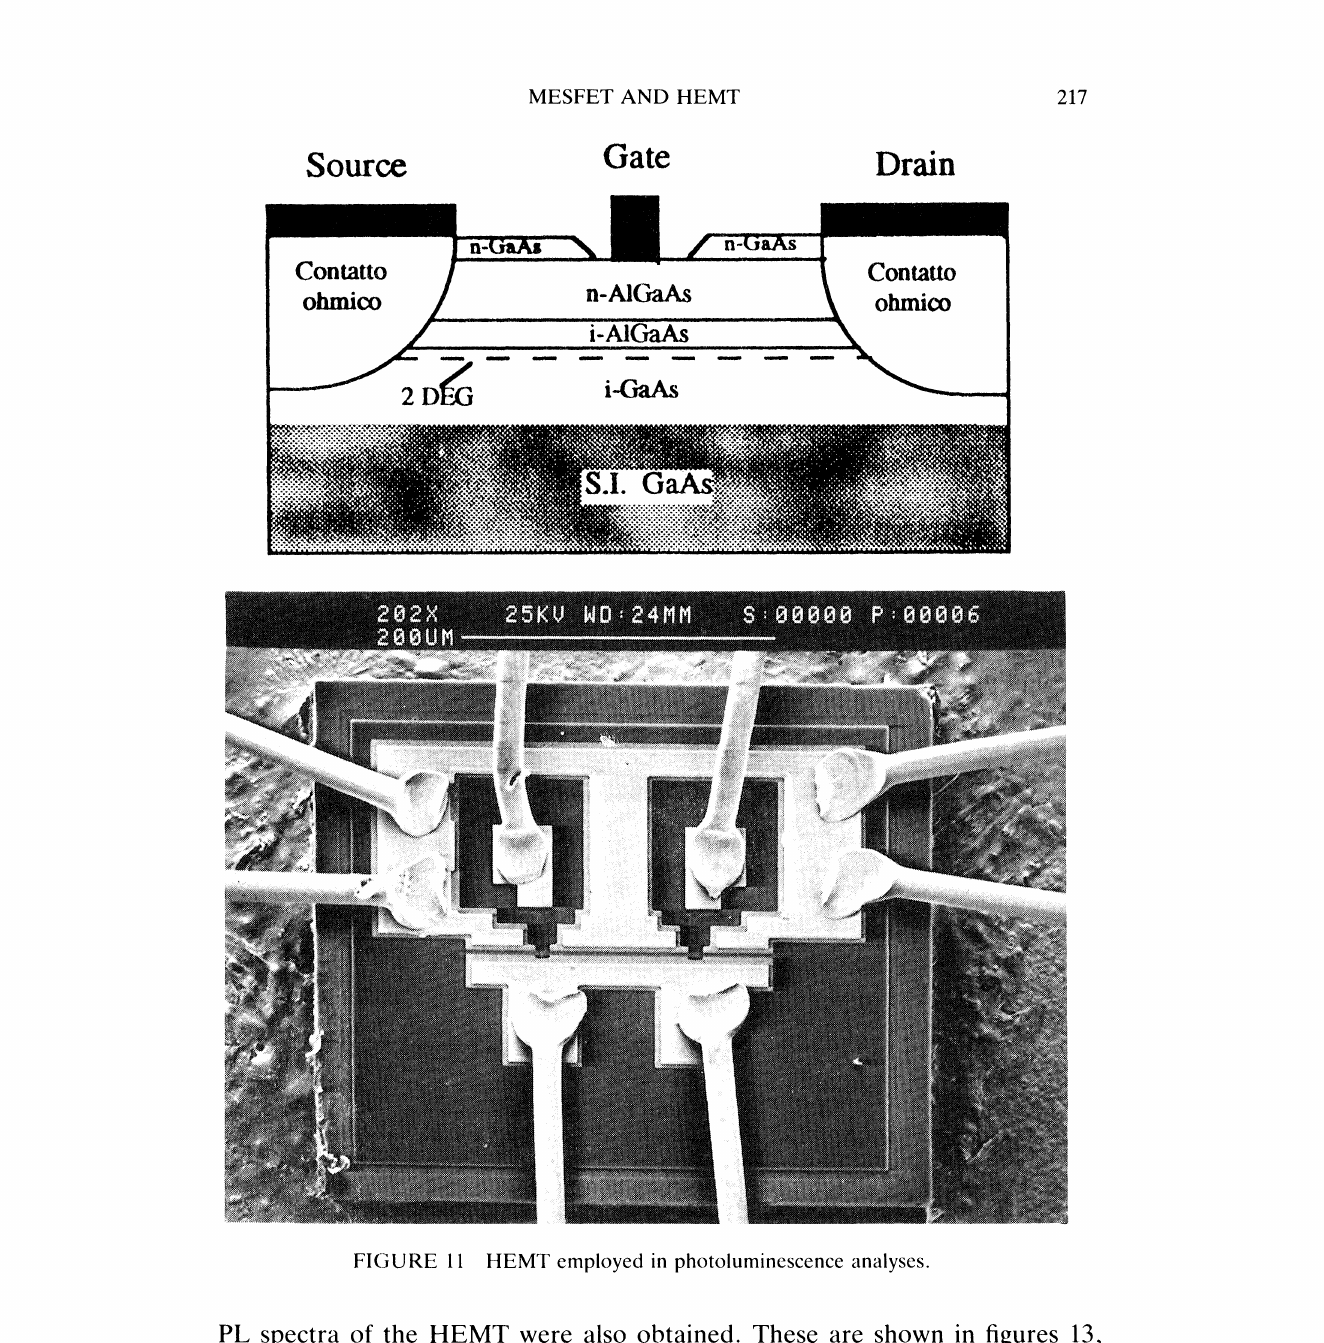
FIGURE 11 HEMT employed in photoluminescence